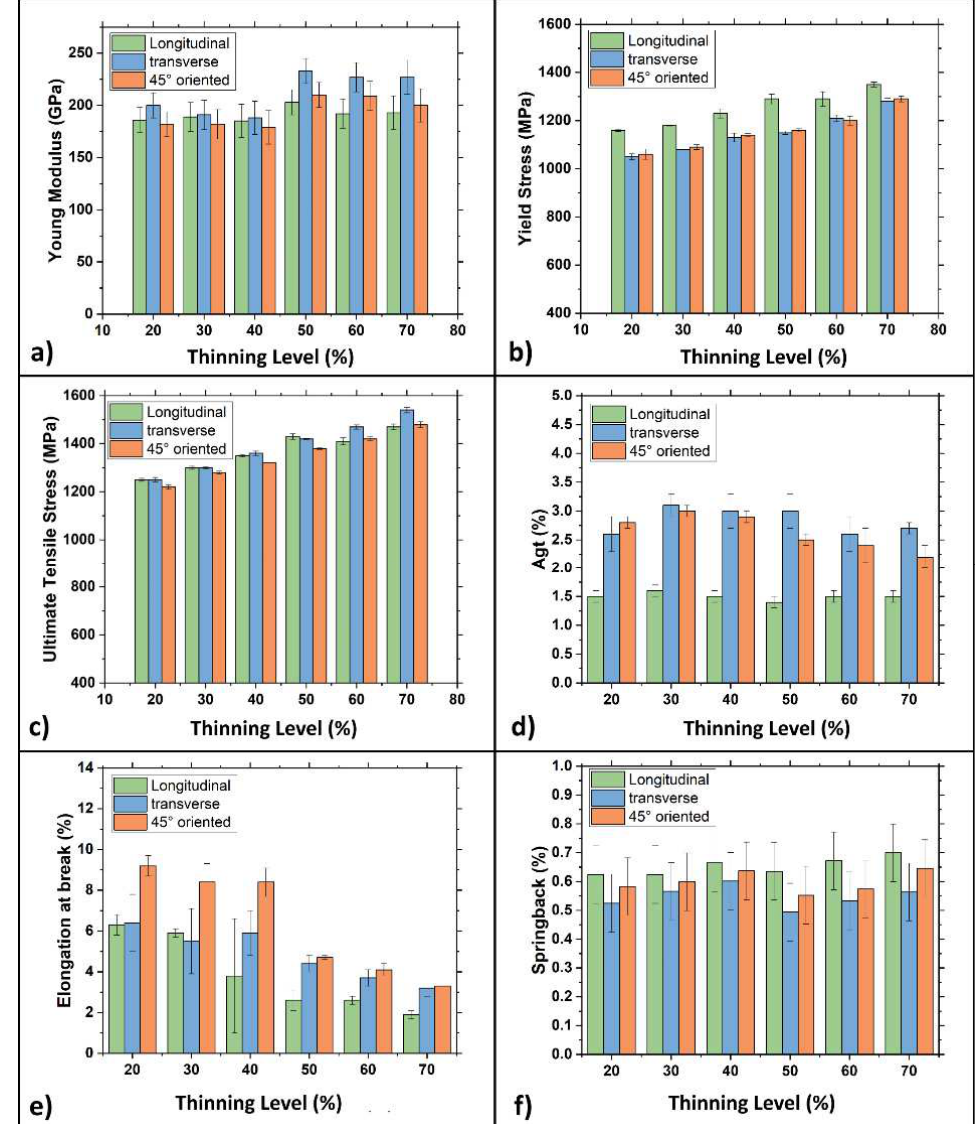
Figure 8. Bar plots of the mechanical properties of the DP steel in all three metallurgical orientations as a function of the thinning levels. ( a ) Young modulus; ( b ) yield stress; ( c ) ultimate tensile stress; ( d ) elongation before sample striction; ( e ) elongation at break; ( f ) springback effect.